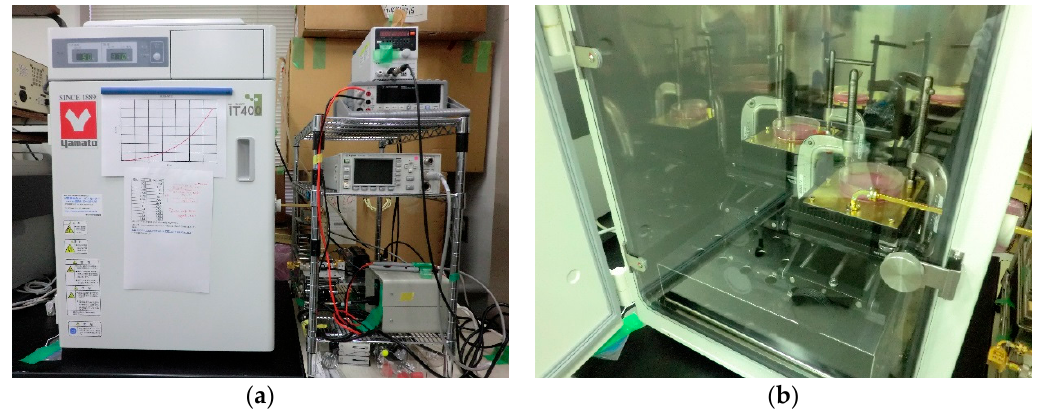
Figure 1. The built-in incubator of the 60 GHz exposure system ( a ) and an inside view of the incubator ( b ). The chamber of the exposure system was maintained under controlled conditions similar to those in an incubator, i.e., an atmosphere of 95% air and 5% CO 2 at a relative humidity of >95% and a temperature of 37 °C.